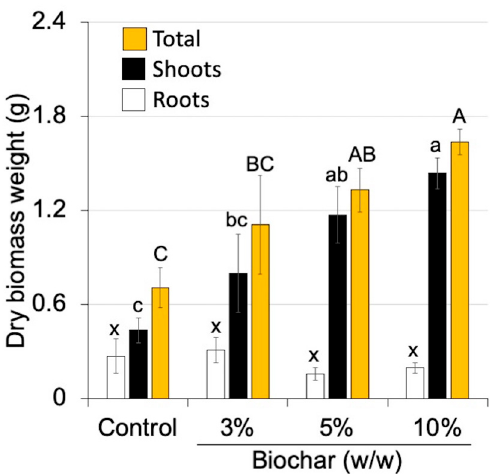
Figure 5. Effects of jatropha fallen leaf biochar application to the experimental soil on the dry biomass weight of Swiss chard plants at harvest (44 days after transplantation). Values are means ± standard deviations of three independent plants. Sets of bars with different letters are significantly different (Holm’s test, p < 0.05).